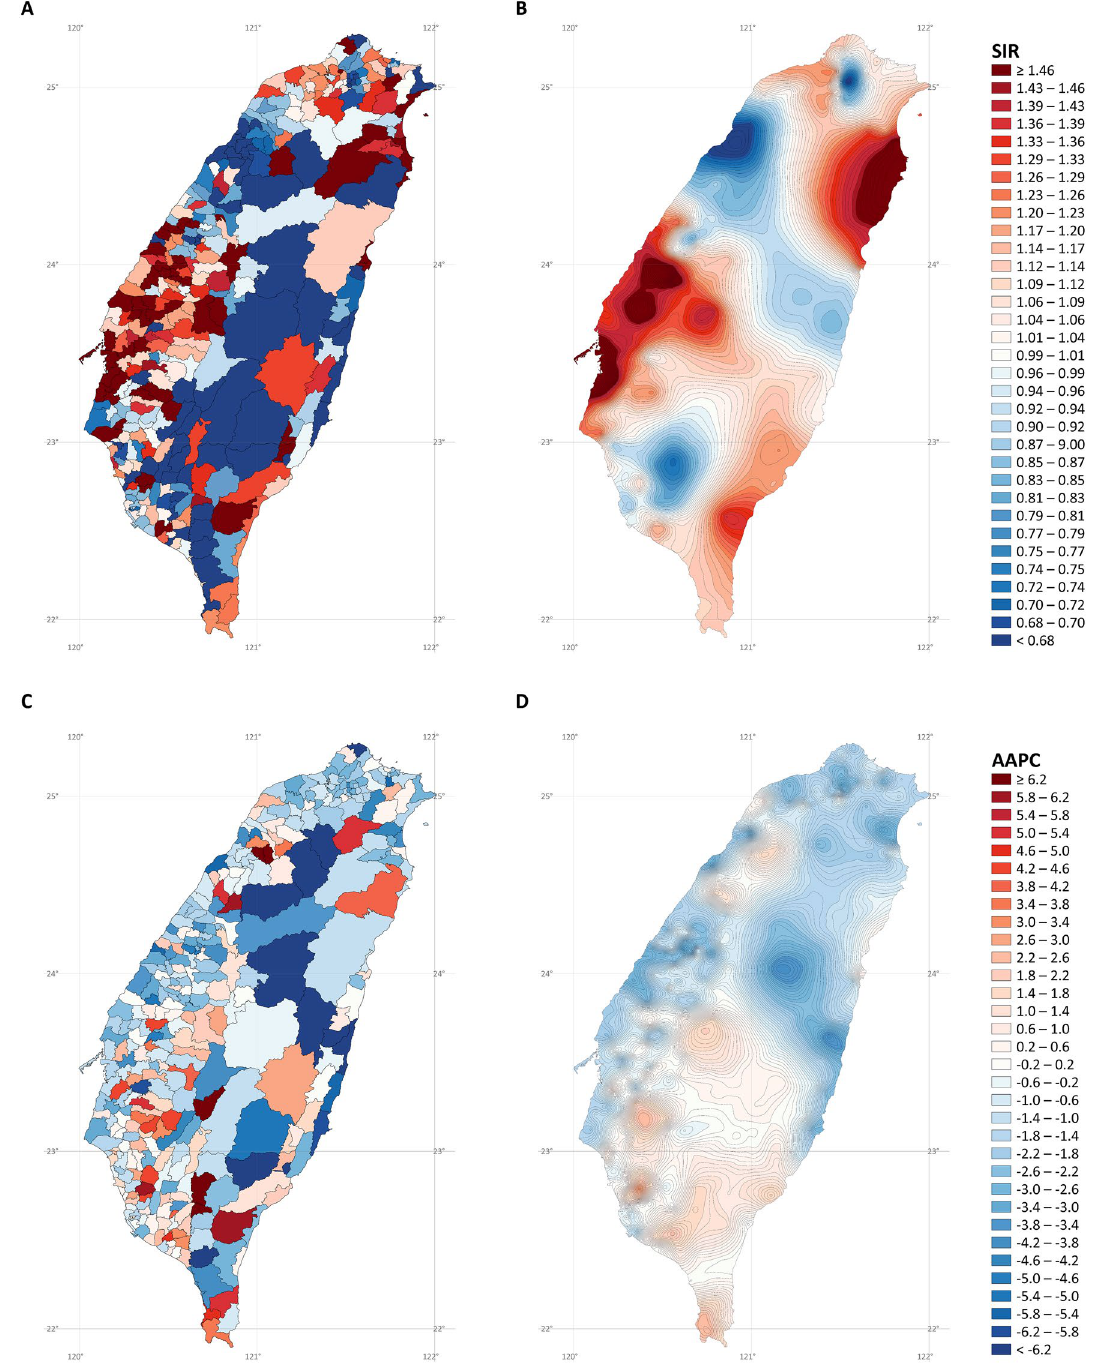
Figure 8. Maps of lung squamous cell carcinoma cancer in males ( A) standardized incidence ratios; ( B) stabilized kriged standardized incidence ratios; ( C) average annual percent changes; ( D) stabilized kriged average annual percent changes). The map was created by R version 3.5.2 with the ggplot2 package (https:// cran.r- proje ct. org/ web/ packa ges/ ggplo t2/ index. matter, SO 2 , NO x , and O 3 ) 32 . The incidence rates of lung adenocarcinoma were lower in southern Taiwan during the early periods, but they eventually increased more rapidly than those in northern Taiwan in more recent years. The finding was probably because the air quality was worse in northern and southern Taiwan in the early period; however, in recent years, air quality has improved in the north and deteriorated in the south 8 . The SIR hotspots of lung adenocarcinoma in Taiwan were also correlated with the geographic distributions of heavy-metal soil contamination with arsenic, copper, nickel, and zinc 37 .